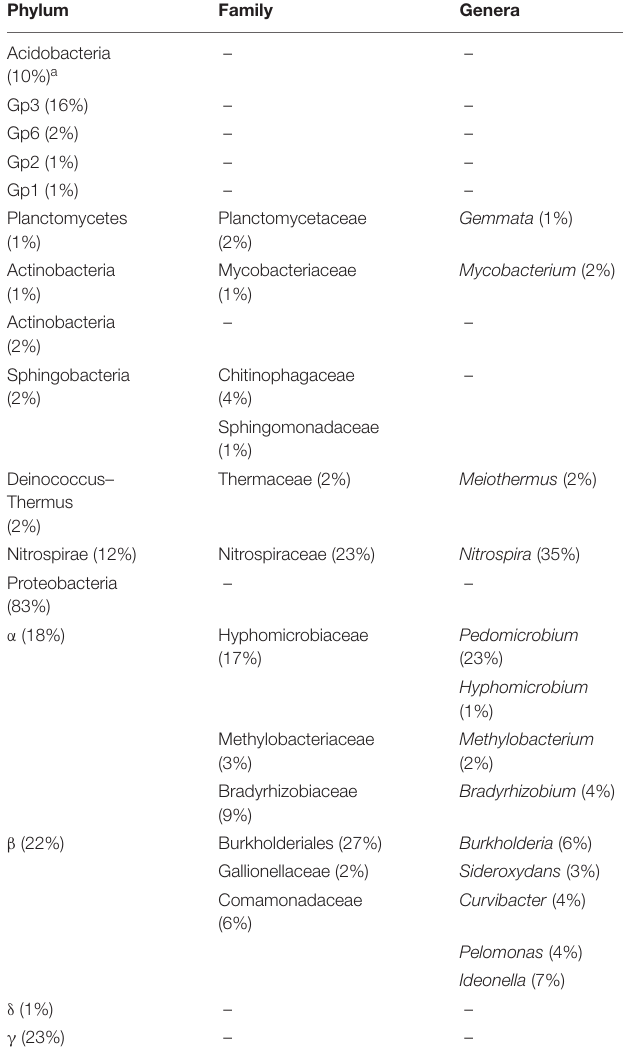
a The percentage of total amplicons corresponding to each taxonomic assignment (OTU cutoff 0.1) are provided in parenthesis. Taxonomic bins containing < 1% to total amplicons are not shown. ‘–’ denotes that no amplicons were confidently